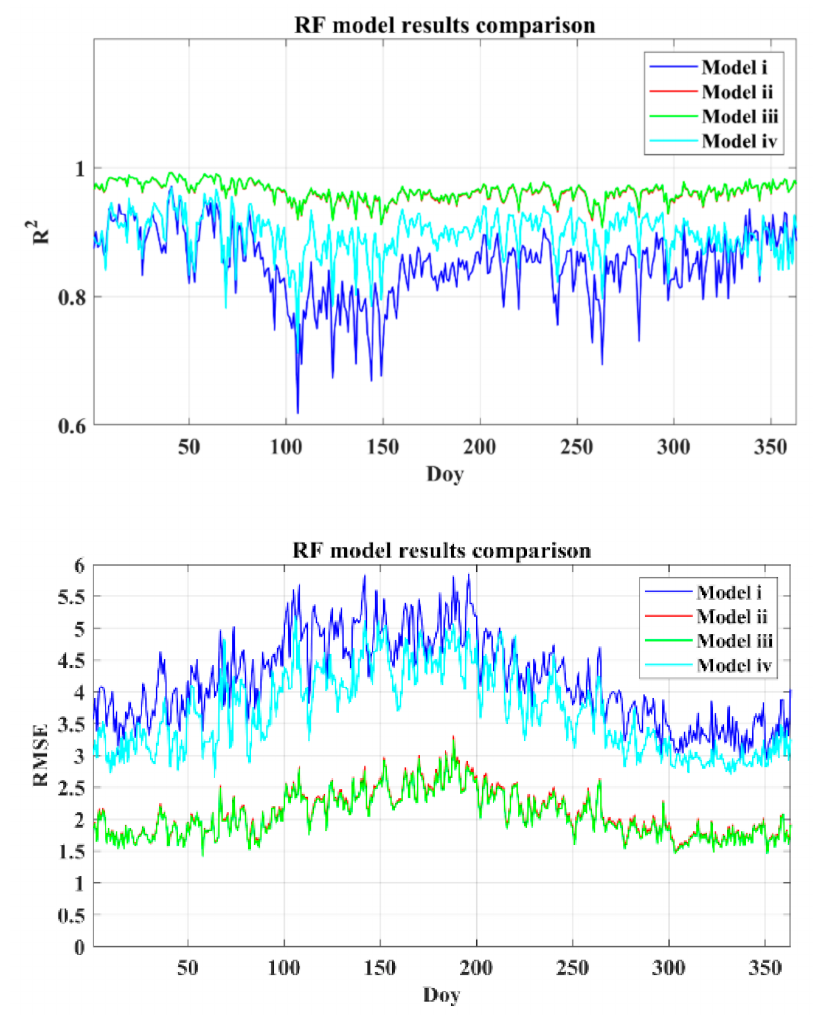
Figure 3. The R 2 and RMSE of the fusion results obtained by the four RF